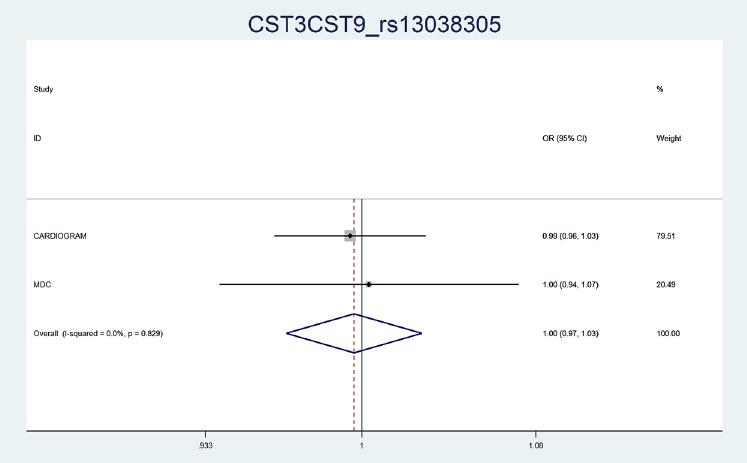
Fig 1. Forest Plot. Meta-analysis of rs13038305 of the cystain C gene and risk of myocardial infarction in the Malmö Diet and Cancer Study (MDC) and CARDIoGRAM. OR = Odds Ratio, CI = confidence interval, weight denotes study weight in the